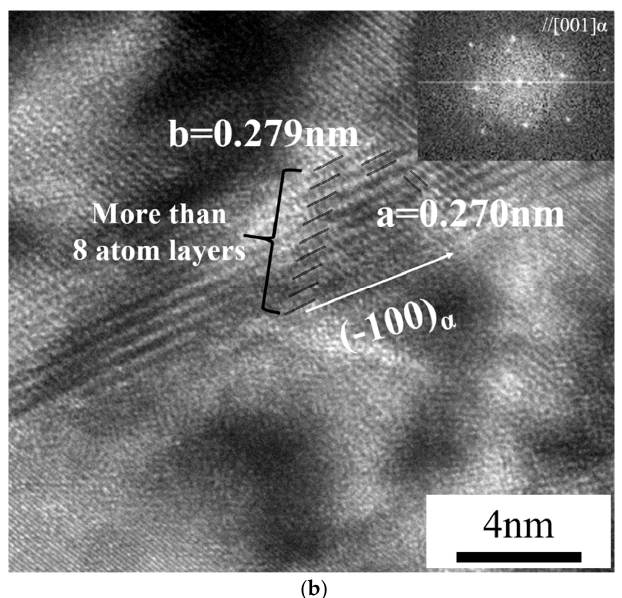
Figure 13. CS-TEM images and SADP outcomes of precipitates consisting of ( a ) γ″ and ( b ) γ′ phases in PWHTed foils.